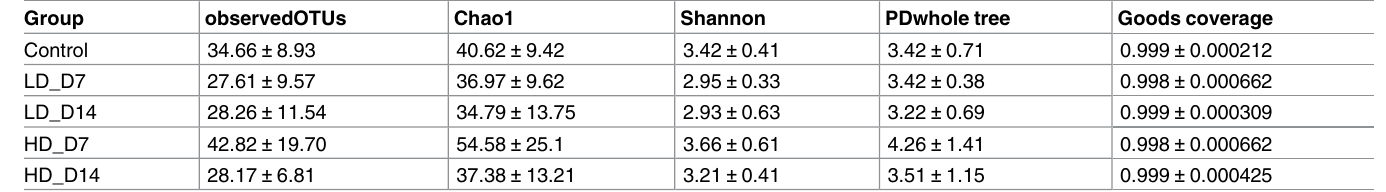
Table 1. Alpha diversity metrics(mean ± standard deviation) of the salmon skin microbial community of the five experimental groups in this study.